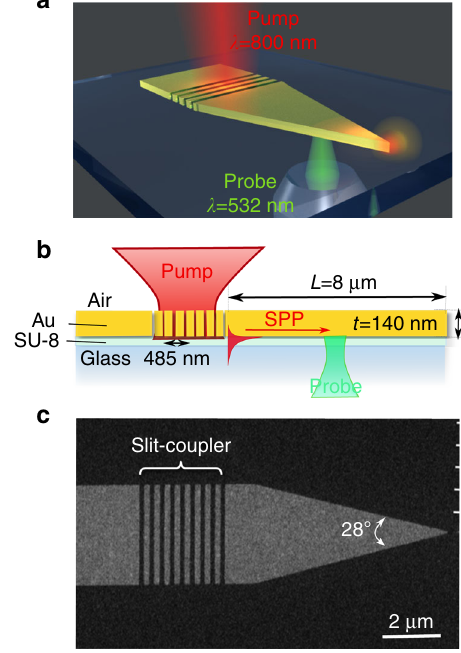
Fig. 1 The plasmonic coupler – taper platform. a A pump pulse is focused from air onto a slit array, and launches SPPs at the dielectric/Au interface that propagate toward the tip apex. The SPP damping is probed by a delayed focused probe beam shown incident from the substrate. b Line shape of the sample. It shows how an SPP can be generated at the dielectric/Au interface and focused adiabatically toward the tip apex.